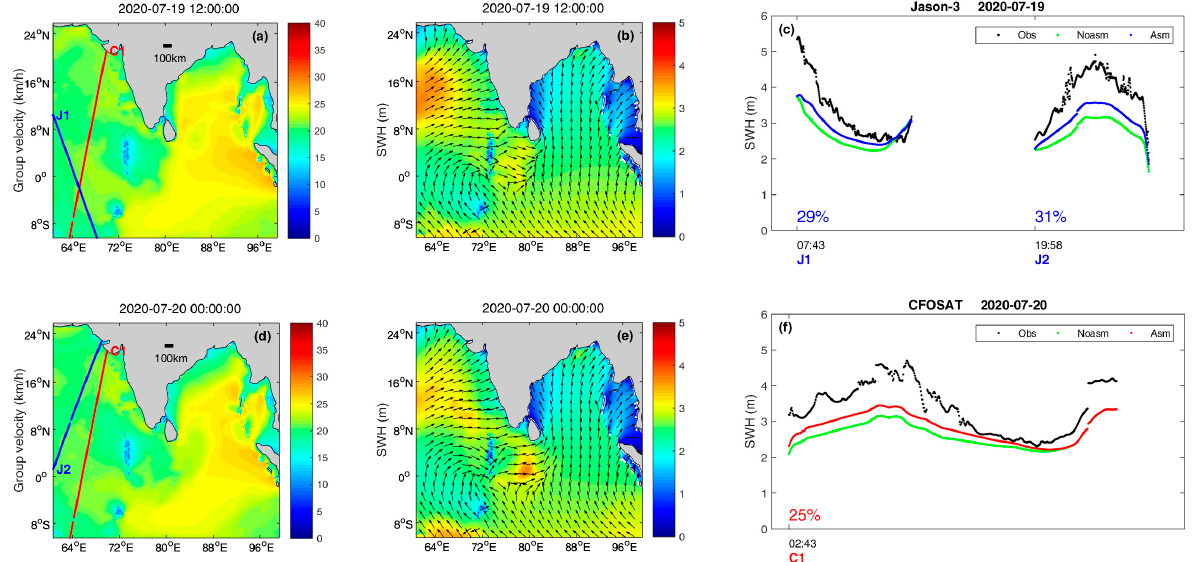
Figure 6. Case A: SWH time series at orbit tracks on 19–20 July 2020. ( a , d ): Color represents group velocity in km/h. Blue and red dotted lines indicate orbit tracks of Jason-3 and CFOSAT, respectively. Location of character J1/J2/C1 indicates the start of the orbit track. ( b , e ): Color and arrows represent SWH and mean wave direction of model outputs without assimilation. ( c ) Black dotted lines indicate Jason-3 measurements; blue and green lines indicate SWH of model outputs with and without assimilation of Jason-3; percentage represents improvement rate of mean absolute error of SWH with assimilation compared to without assimilation. ( f ) Black dotted lines indicate CFOSAT measurements; red lines and green lines indicate SWH of model outputs with and without assimilation of Jason-3; percentage represents improvement rate of mean absolute error of SWH with assimilation compared to without assimilation.